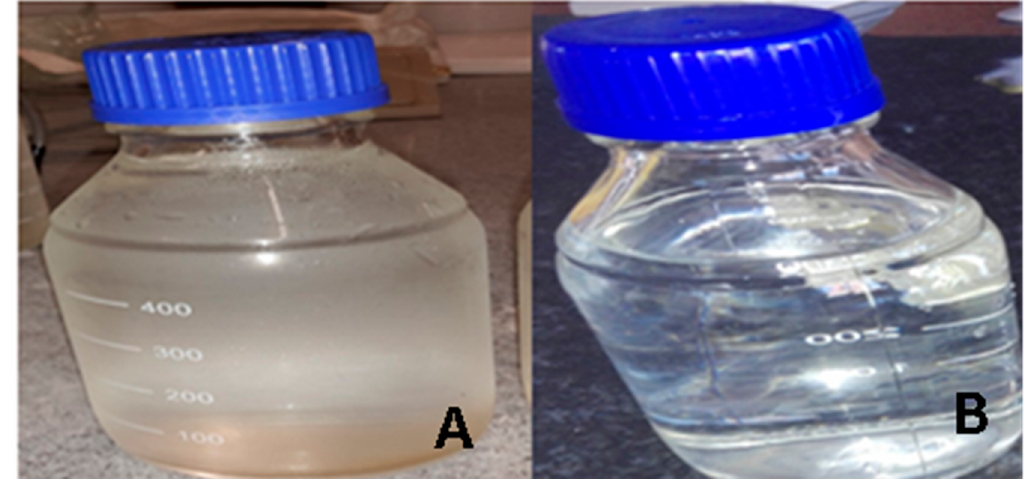
Figure 9. Quality of water produced in the rural area ( A ) and urban areas ( B ) of Ugu District Figure9. Qualityofwaterproducedintheruralarea( A )andurbanareas( B Municipality.